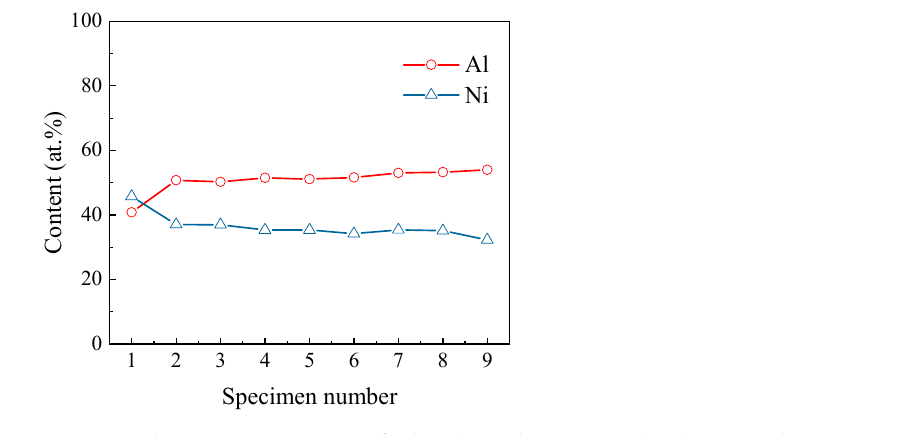
Figure 7. The variation pattern of Al and Ni elements in the aluminized specimens’ outermost layer (zone I).